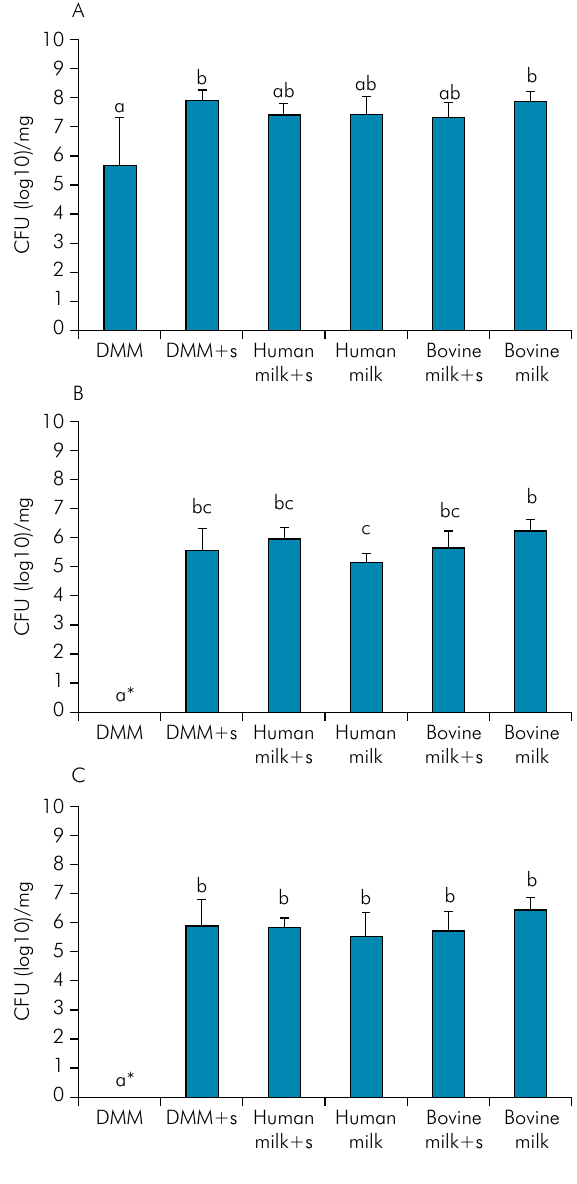
Figure 2. a. CFU values of total microorganisms grown onto blood agar, according to the growth condition after 5 days. Distinct letters indicate significant difference among groups (p < 0.05). b. CFU values of total aciduric bacteria grown onto brain heart infusion adjusted to pH 4.8 according to the growth condition after 5 days. Distinct letters indicate significant difference among groups (p < 0.05). c. CFU values of lactobacilli grown onto rogosa agar according to the growth condition after 5 days. Distinct letters indicate significant difference among groups (p <